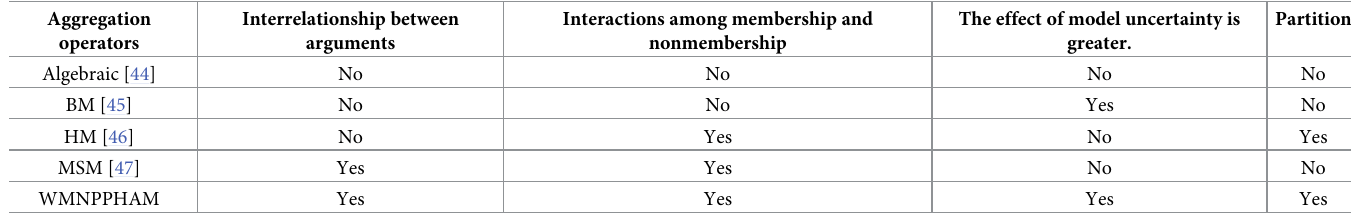
Table 4. The comparison results of the different methods. Aggregation